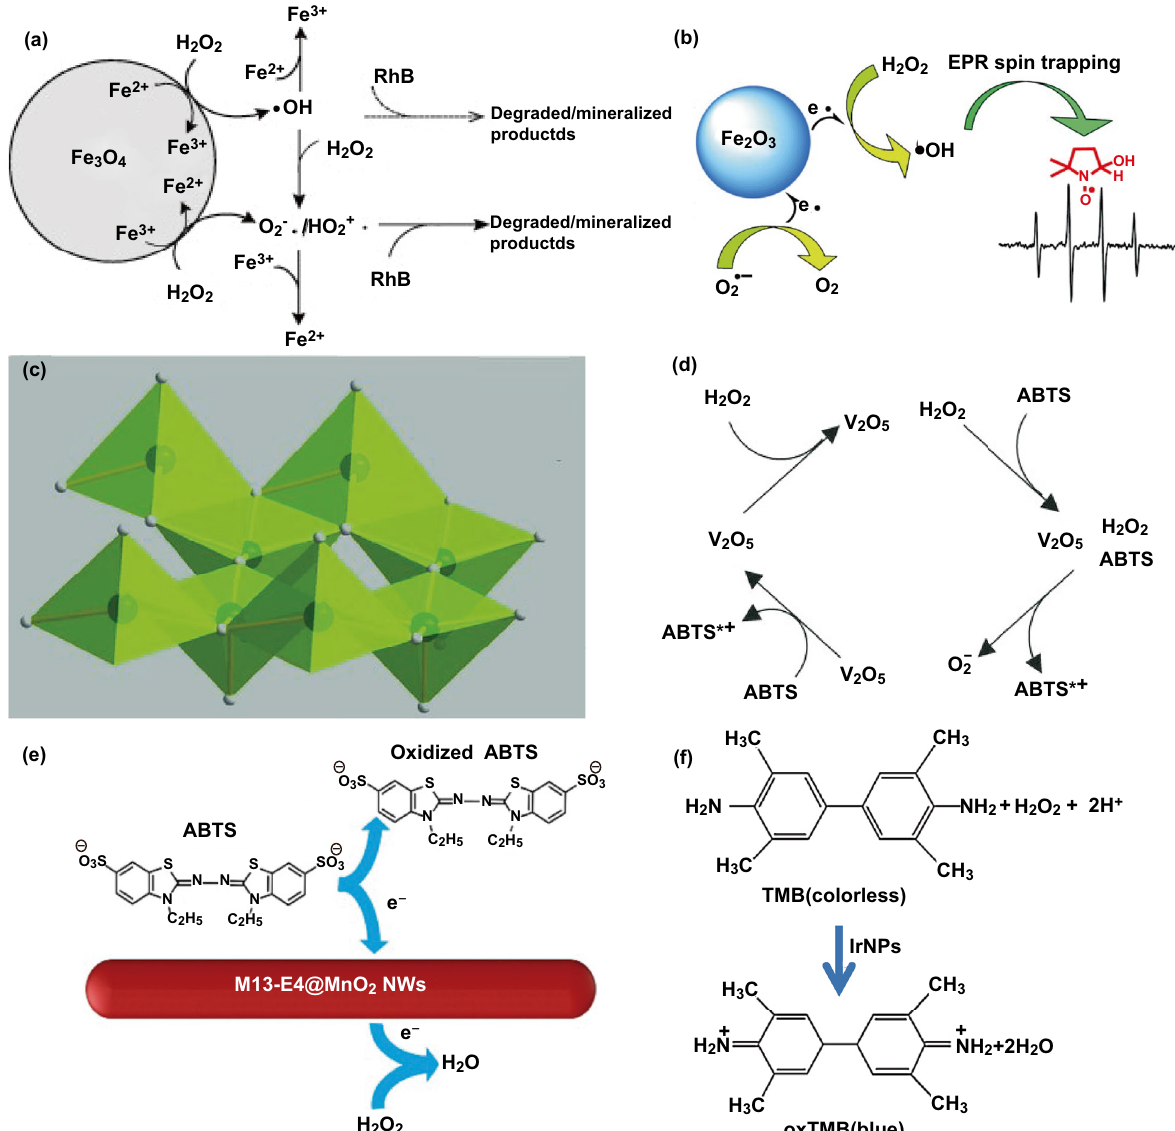
Fig. 3 a Mechanism for the POD-like activity of Fe 3 O 4 MNPs in the degradation of organic pollutants. b Mechanism mediated by γ-Fe 2 O 3 NPs. c View of Single layer from the V 2 O 5 structure. d Possible mechanism for the catalytic reaction of the V 2 O 5 NWs. e Catalytic mechanism of M13-E4@MnO 2 NWs with POD-type properties. f Corresponding reaction equation of TMB oxidized by H 2 O 2 with the Ir NPs as POD mimics. ABTS (2,2’-azino-bis(3-ethylbenzothiazoline-6-sulfonic acid)). Adapted from a Ref. [187], b Ref. [188], c , d Ref. [189], e Ref. [9], f Ref. [71] with